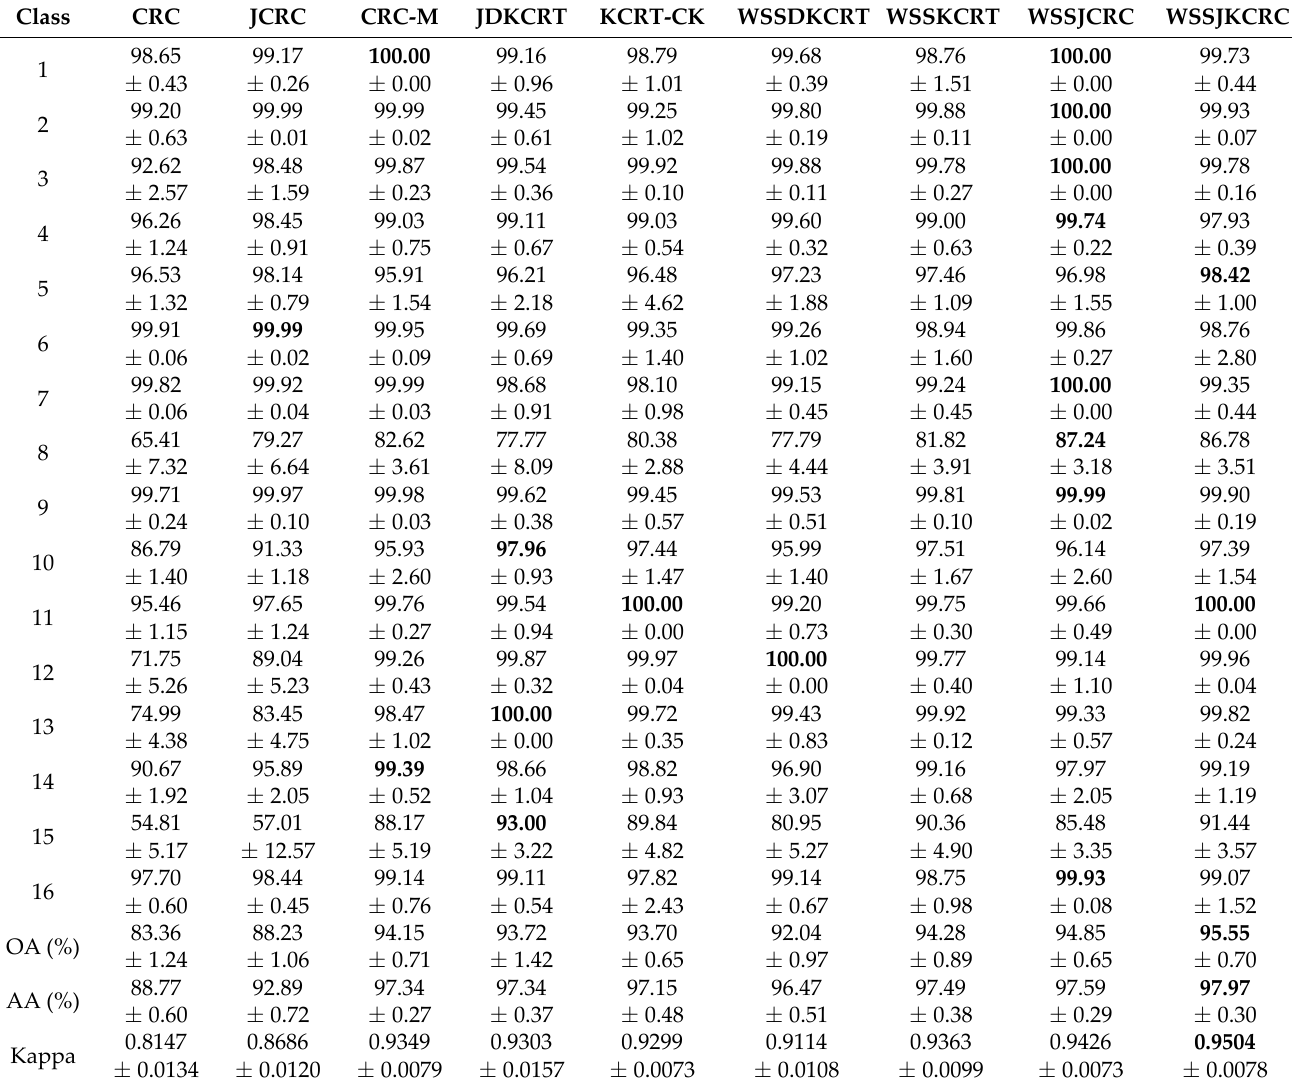
Table 6. Land cover classification accuracy with STD for different methods on the Salinas